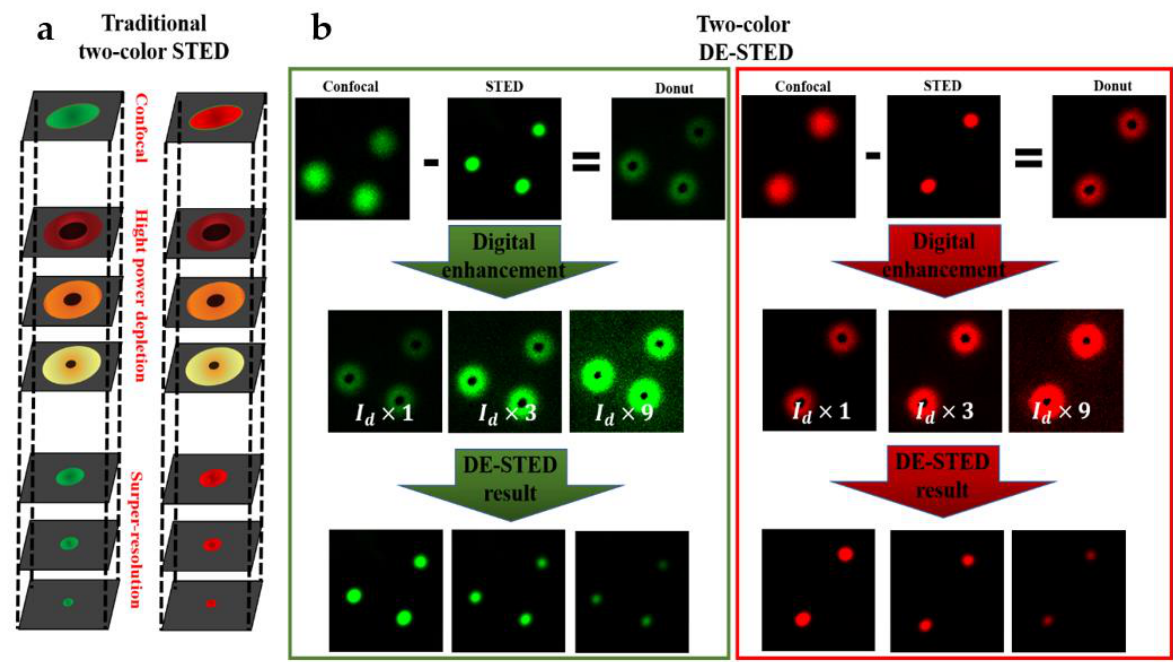
Figure 2. Schematic principles of two-color DE-STED. ( a ) The principle of traditional two-color STED. ( b ) The principle of two-color DE-STED.